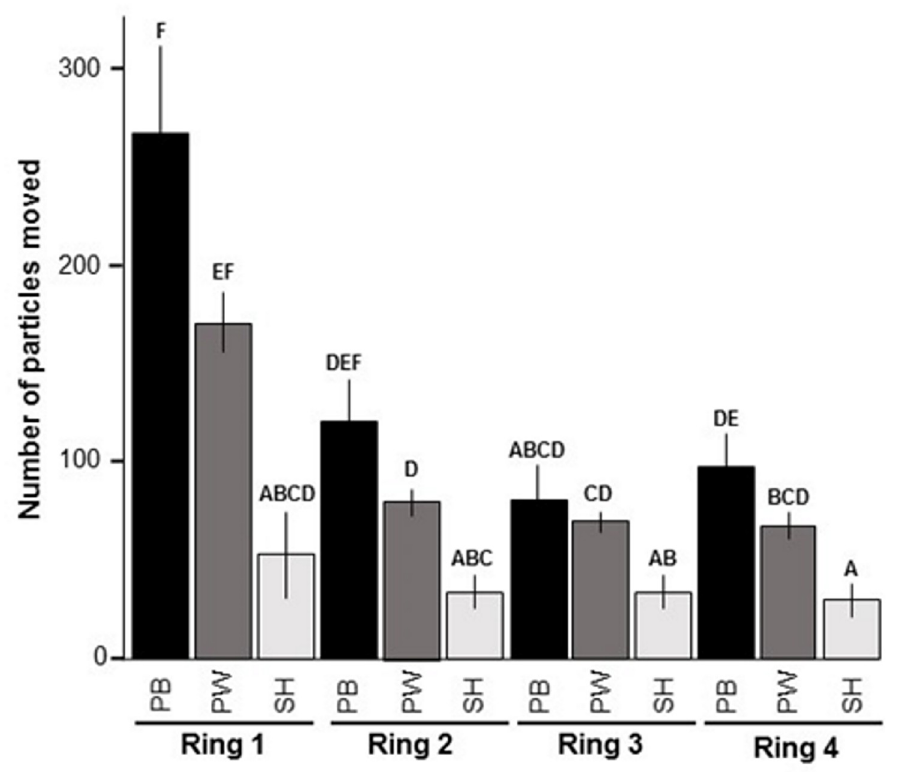
Fig 1. Number of particles moved horizontally over the four defined rings (with ring 1 = 1 cm, ring 2 = 2 cm, ring 3 = 3 cm and ring 4 = 4 cm diameter) around the feeding station by Folsomia candida at the end of the experiment (after ten days). The shading of bars represents the different biochar types used (black = PB, pine bark; dark grey = PW, pine wood; light grey = SH, spelt husks). Mean ± SE, n = 8. Bars with same letters are not significantly different according to pairwise comparisons of least square means at alpha level 0.05. Controls were 0, hence not shown.